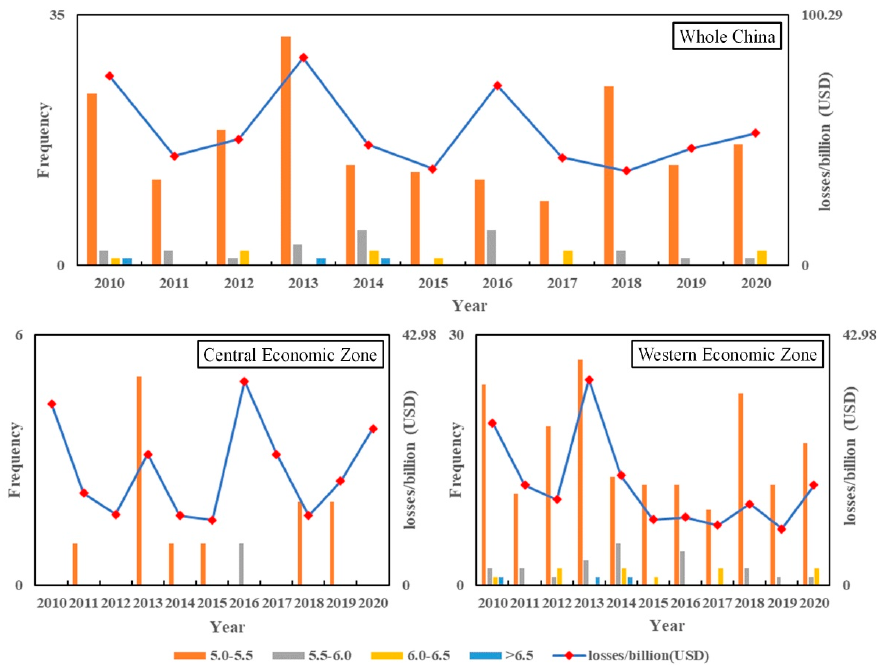
Figure 7. The distributions of earthquake frequency (bar chart) and natural disasters losses (blue line) each year in the period 2010–2020. Table 4. The correlation coefficient between earthquake occurrence and natural disasters losses in each region. Central Whole China Whole